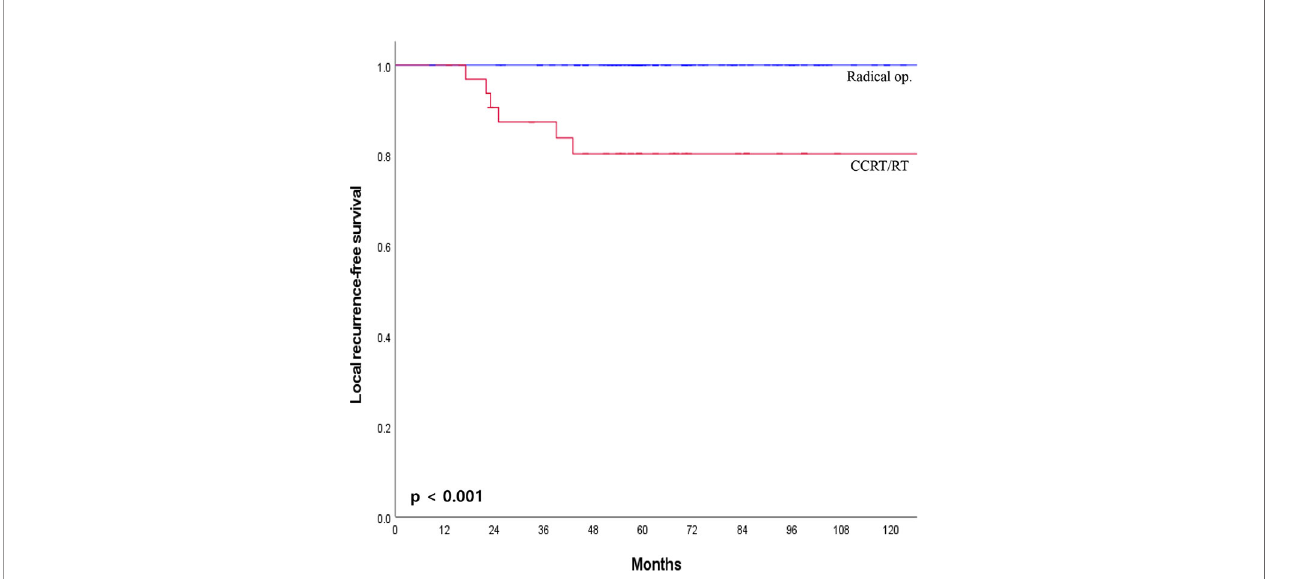
FIGURE 3 | Local recurrence-free survival curves of patients with early rectal cancer between CCRT/RT and radical operation groups.